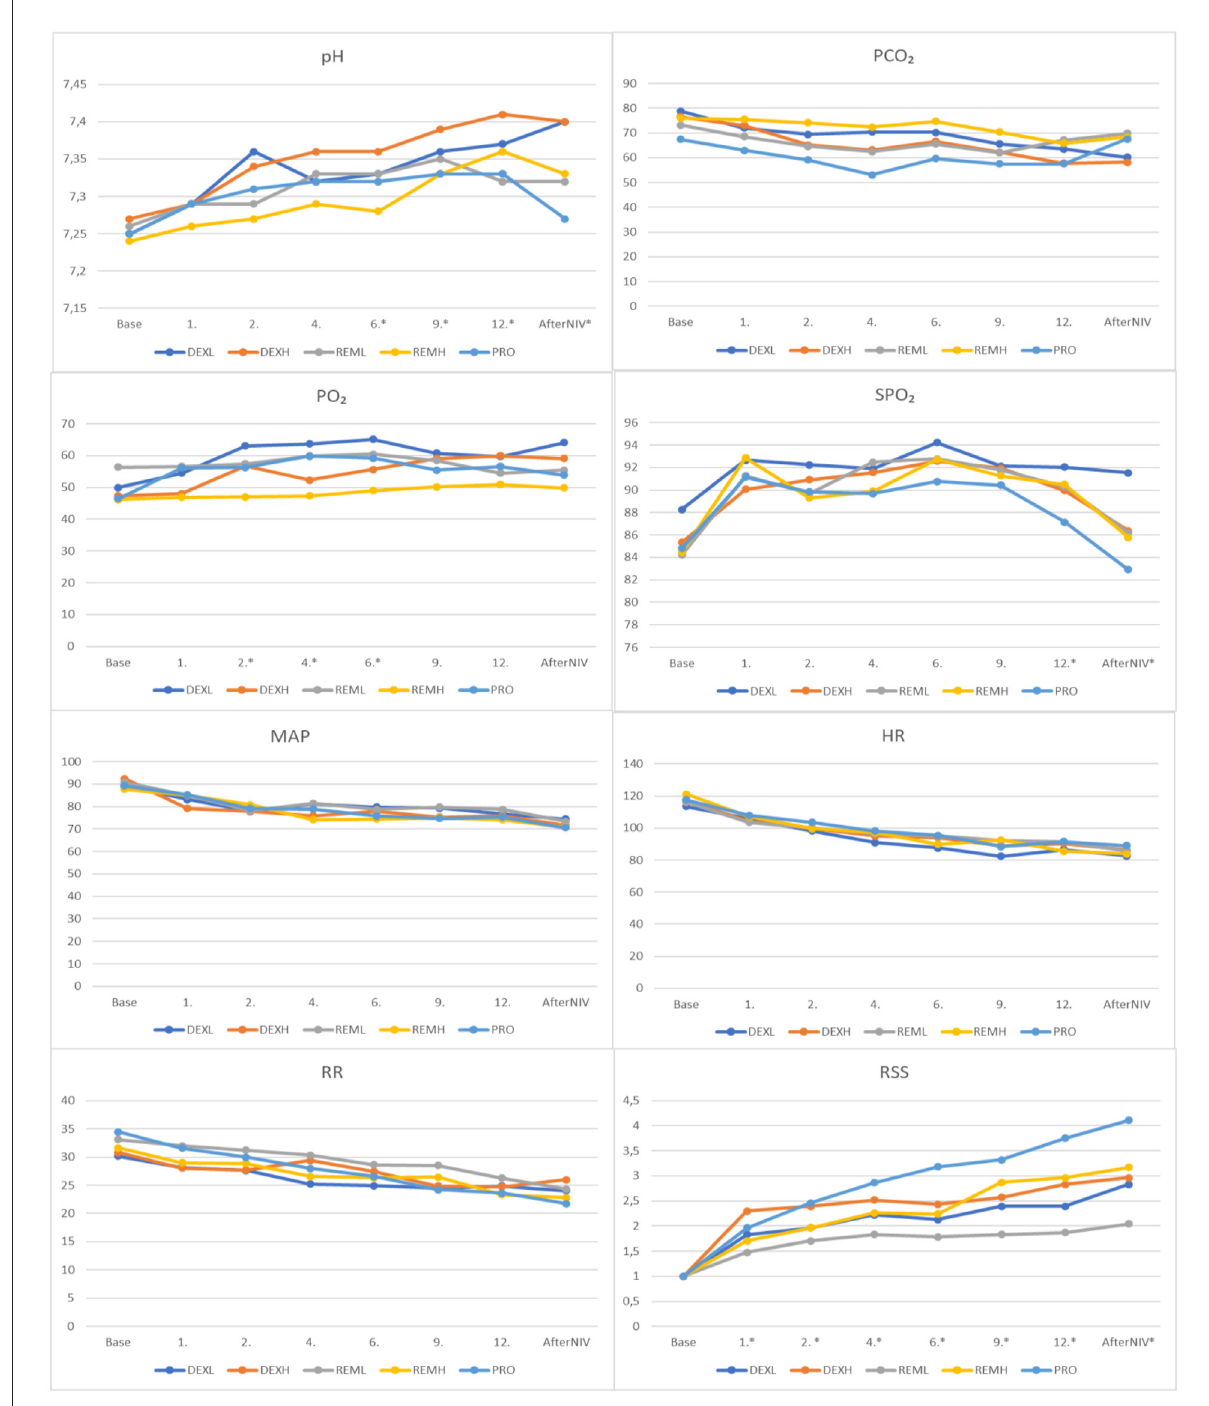
FIGURE2 Comparison of study groups according to blood gas results, RSS and monitoring records. RSS, Ramsay Sedation Scale; SpO 2 , peripheral oxygen saturation; RR, respiratory rate; HR, heart rate; MAP, mean arterial pressure; pH, potential of hydrogen; PCO 2 , partial pressure of carbon dioxide; PO 2 , partial pressure of oxygen. * P <